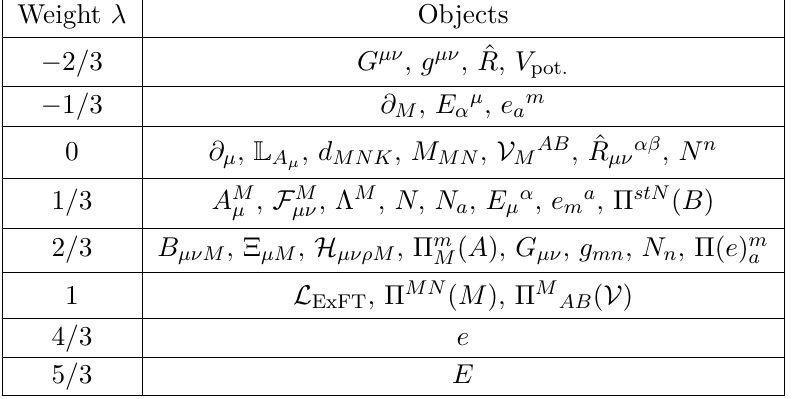
Table 4 . The generalised exceptional diffeomorphism weights of the most important objects of canonical E exceptional field 6(6)